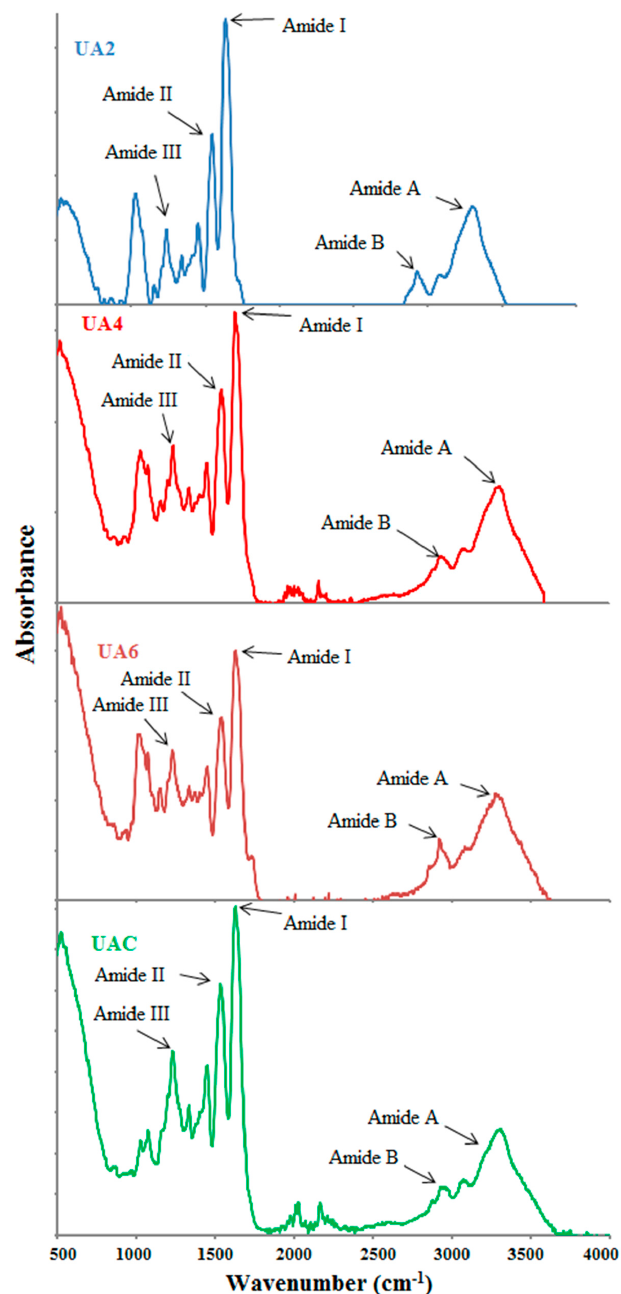
Figure 2. FTIR spectra of gelatin extracted using ultrasound for the time duration of 2, 4 and 6 h (UA2, UA4 and UA6, respectively) with actinidin pretreatment. UAC: control gelatin extracted using ultrasound without enzyme pretreatment.